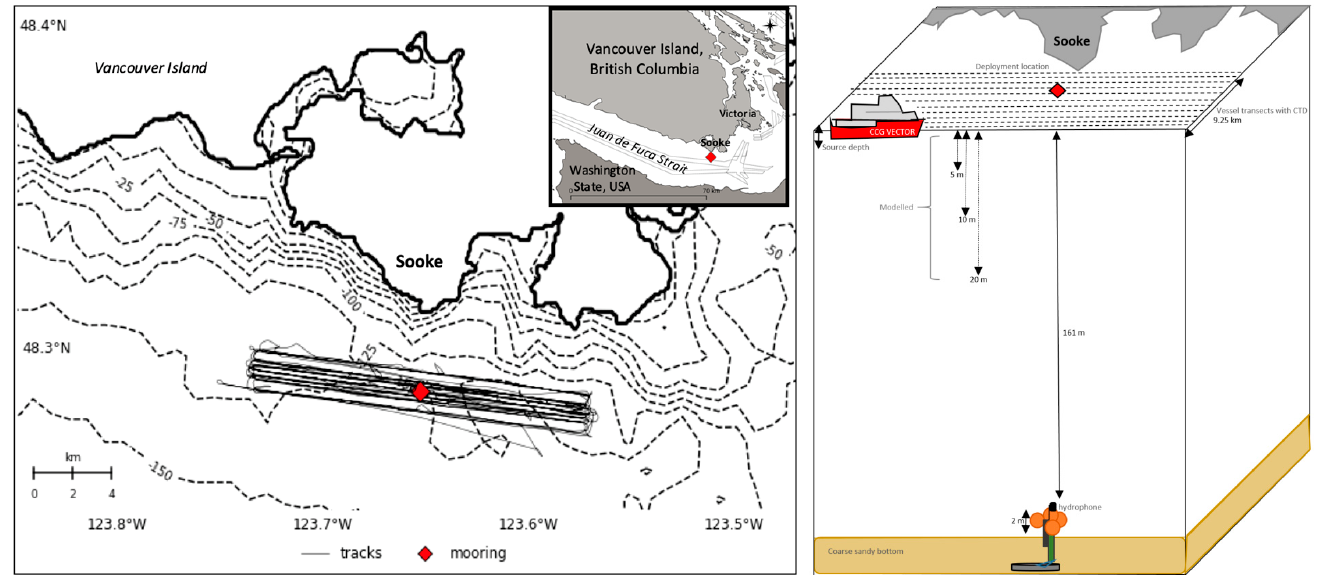
Figure 1. ( a ) Passive acoustic mooring location at Sooke in the Juan de Fuca Strait and vessel transects of the CCGS Vector, completed between 12–14 October 2018 to a maximum distance of 9.25 km from the mooring. Location of shipping lanes through the Juan de Fuca Strait are indicated by dashed lines in the inset. Depth contours in meters. ( b ) A schematic sectional plan of the experiment design showing the hydrophone at 161 m for observed measures and the interpolated assessments of the sound field at 5 m, 10 m and 20